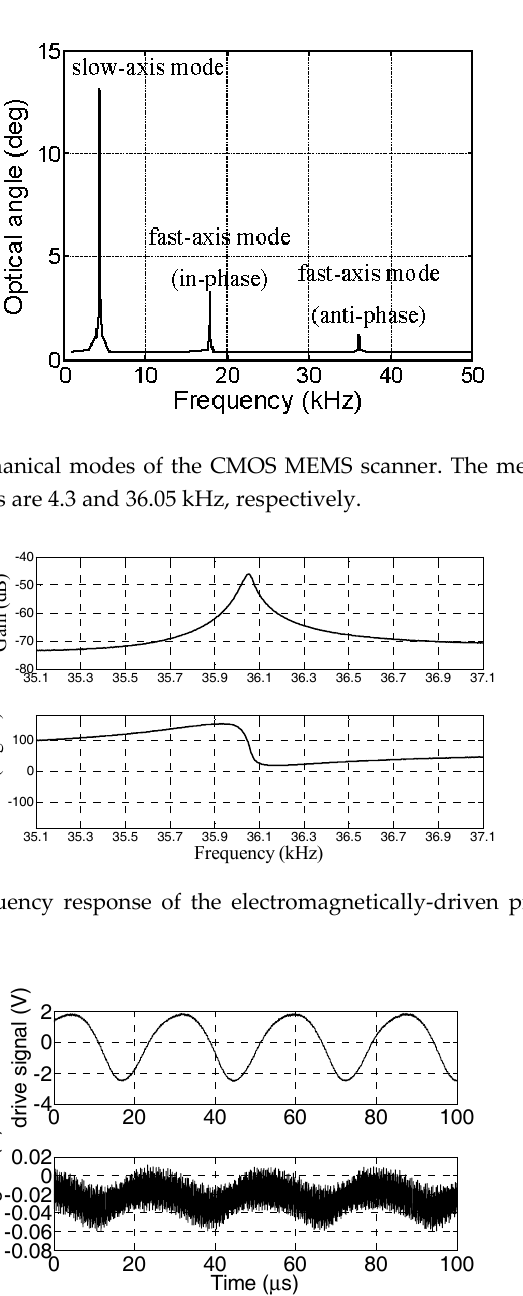
Figure 7. Measured sensed and driving signals when the anti-phase mode is driven to oscillation by closed-loop operation.